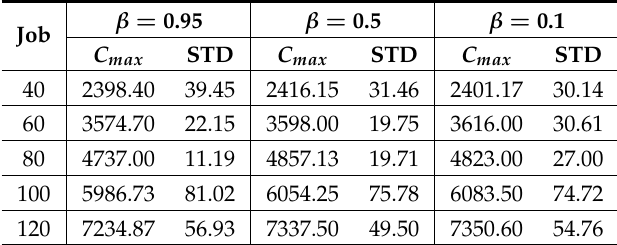
Table 12. Influence of the β on the performance of the